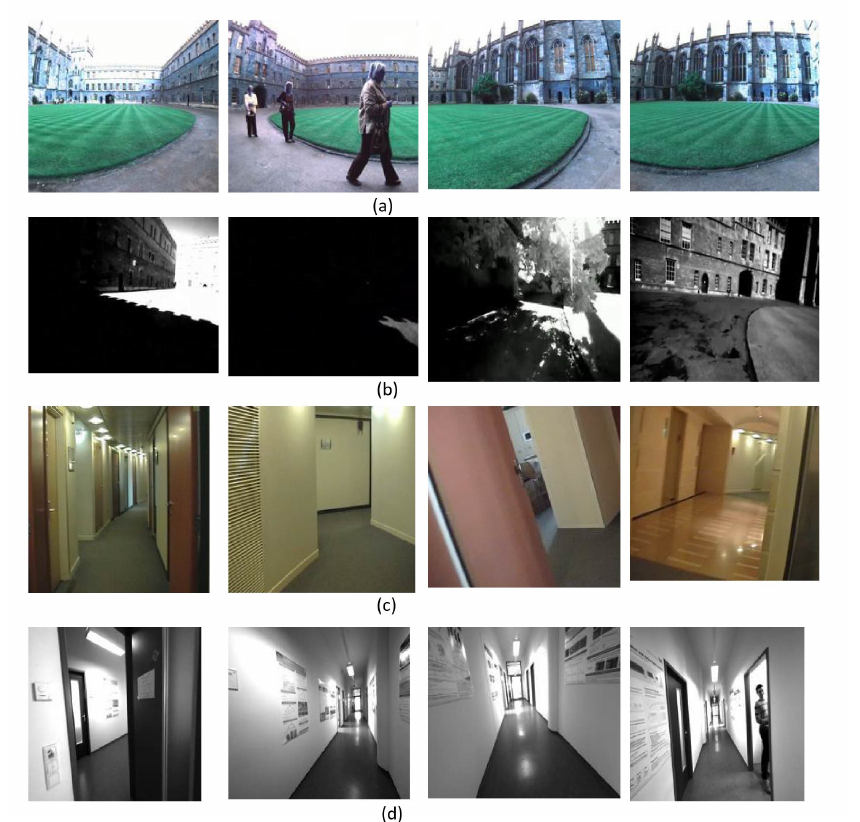
Figure 10. Example of datasets used in Ultrametric-FABMAP. Table 5. Comparison of FABMAP2, Ultrametric-FABMAP and BOW considering Ultrametric- FABMAP as our ground truth.